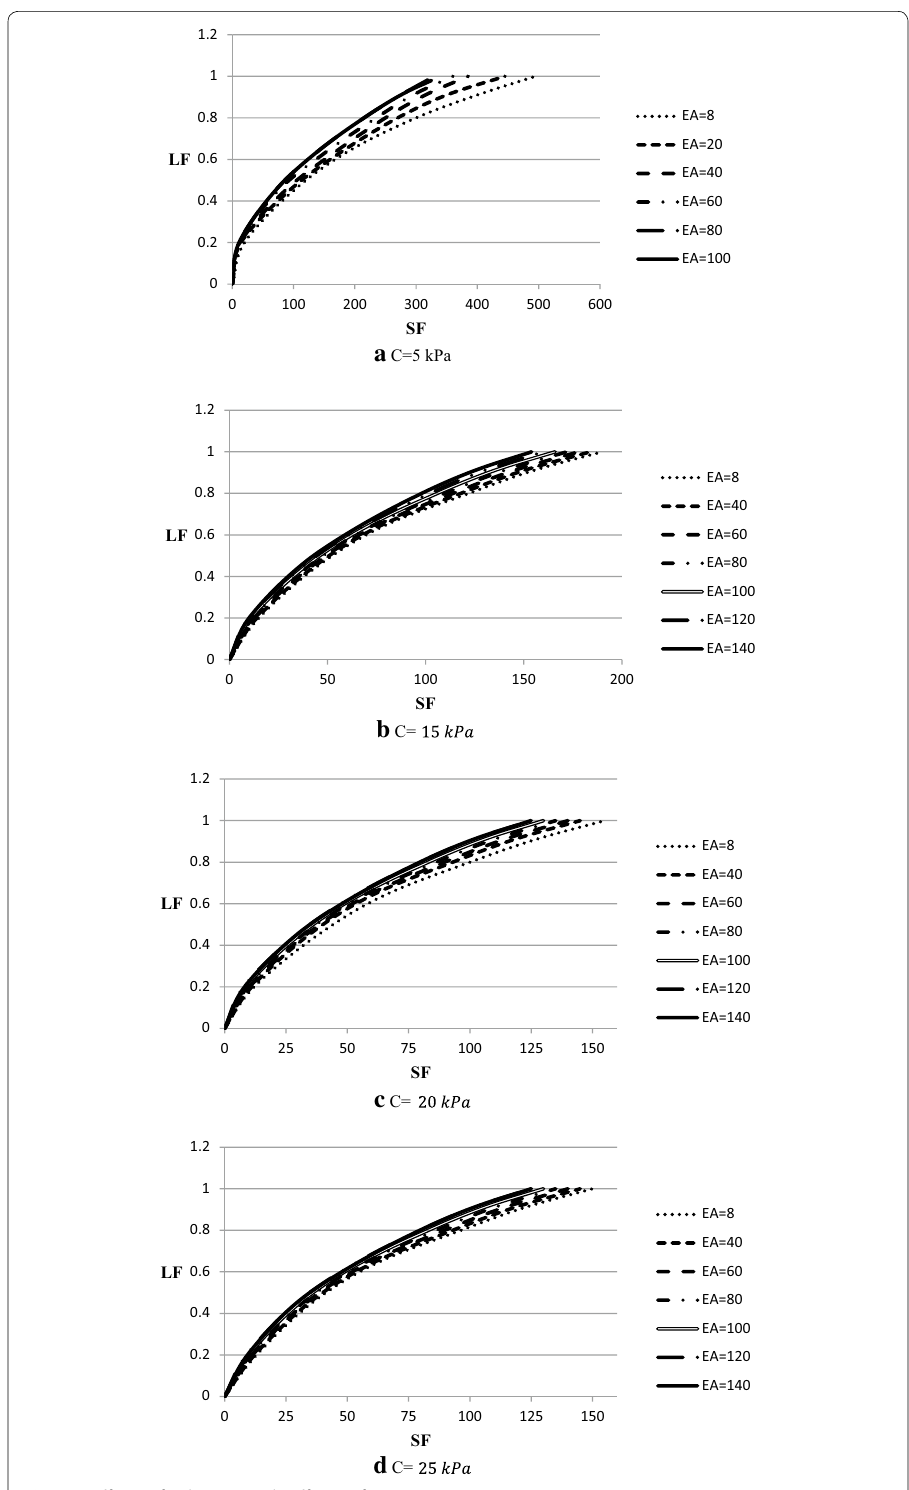
Fig. 13 Effects of cohesion and stiffness of